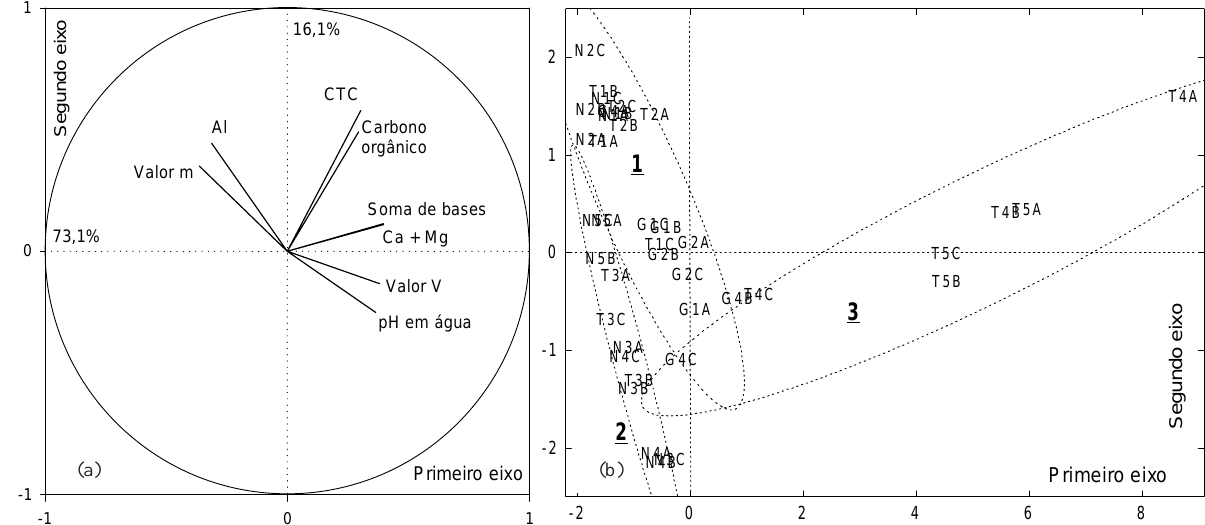
Figura 4. Análise de componentes principais de variáveis relacionadas com a oferta de nutrientes pelo solo para as 39 amostras de horizontes superficiais. (a) Círculo de autovetores das variáveis; (b) Plano de elipses e dispersão de pontos dos grupos de perfis de solos. Pontos como códigos de cada perfil. Elipses: 1 = solos de textura argilosa a muito argilosa, hipo a mesoférricos; 2 = solos de textura média a arenosa, hipoférricos; 3 = solos de textura argilosa a muito argilosa,